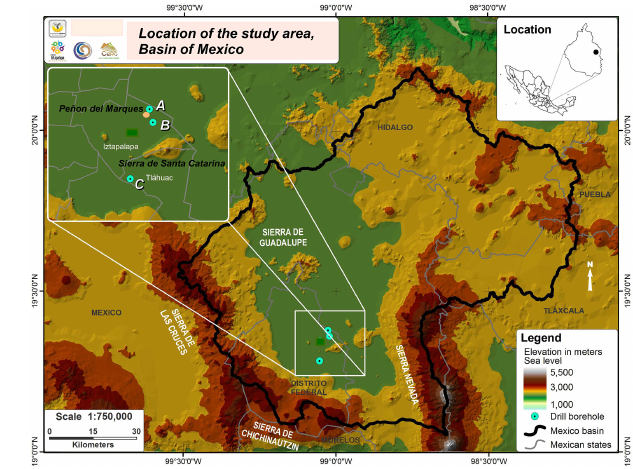
Figure 1. Location of the study areas in the Basin of Mexico (black polygon), Iztapalapa and Tlahuac. The geotechnical bore- hole locations are shown by blue circles: (A) La Cascada, (B) Lu- cio Blanco, (C) Tlahuac. Lacustrine planes are shown in green and volcanic structures in yellow and red. Grey lines indicate adminis- trative